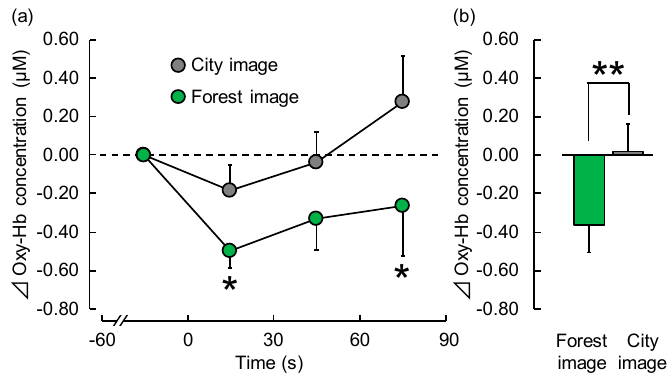
Figure 5. Thirty-second average and overall mean oxyhemoglobin (oxy-Hb) concentration in the right prefrontal cortex during visual stimulation with forest and city images. ( a ) Changes in each 30 s average oxy-Hb concentration over 90 s. ( b ) Overall mean oxy-Hb concentrations. Data are expressed as means ± standard errors, n = 17, * p < 0.05, ** p < 0.01, as determined by the paired t -test (one-sided); the Holm correction was applied.